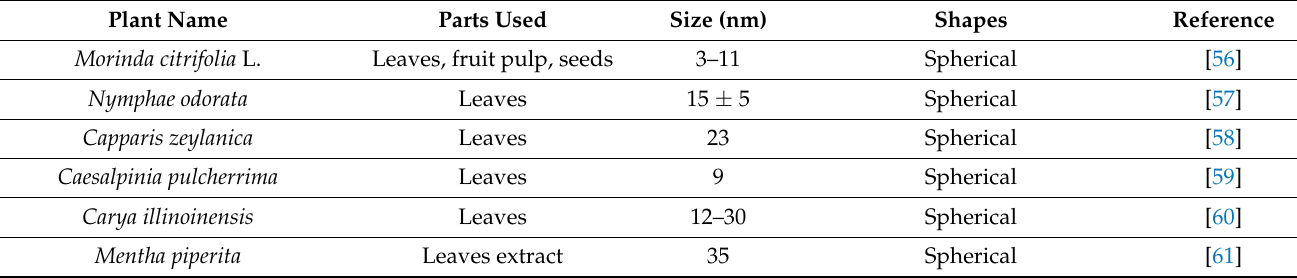
Table 1. Plant-assisted synthesis of silver